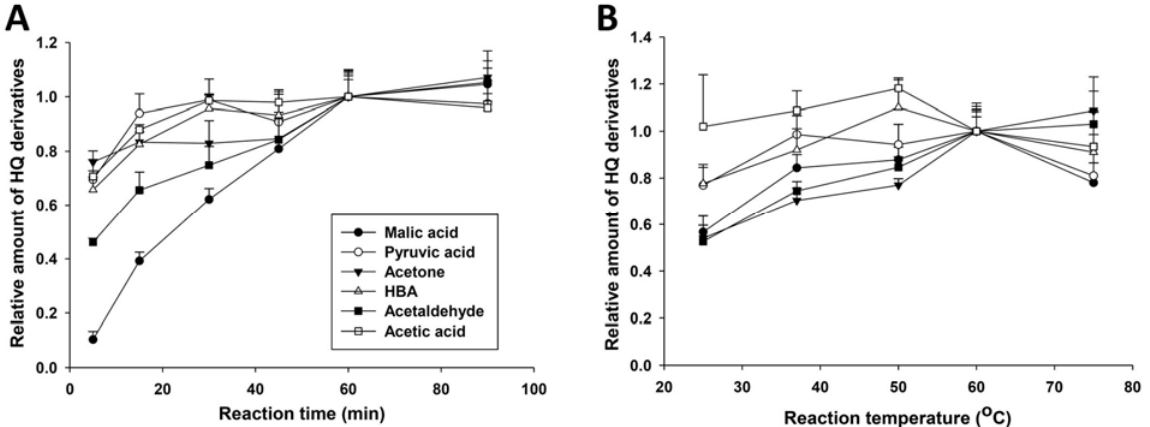
Figure 3. Optimization of HQ derivatization reactions. ( A ). Effect of reaction time on HQ derivatization; ( B ) effect of reaction temperature on HQ derivatization. The amounts of HQ derivatives formed by the incubations at 60 °C for 60 min were arbitrarily set as one. Experimental values are expressed as the mean ± standard deviation